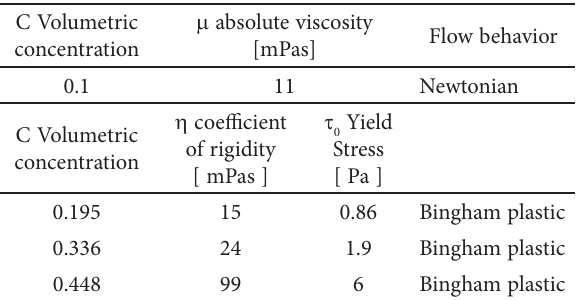
= 160 m m, r = 1630 kg/m 3 ) 95 s